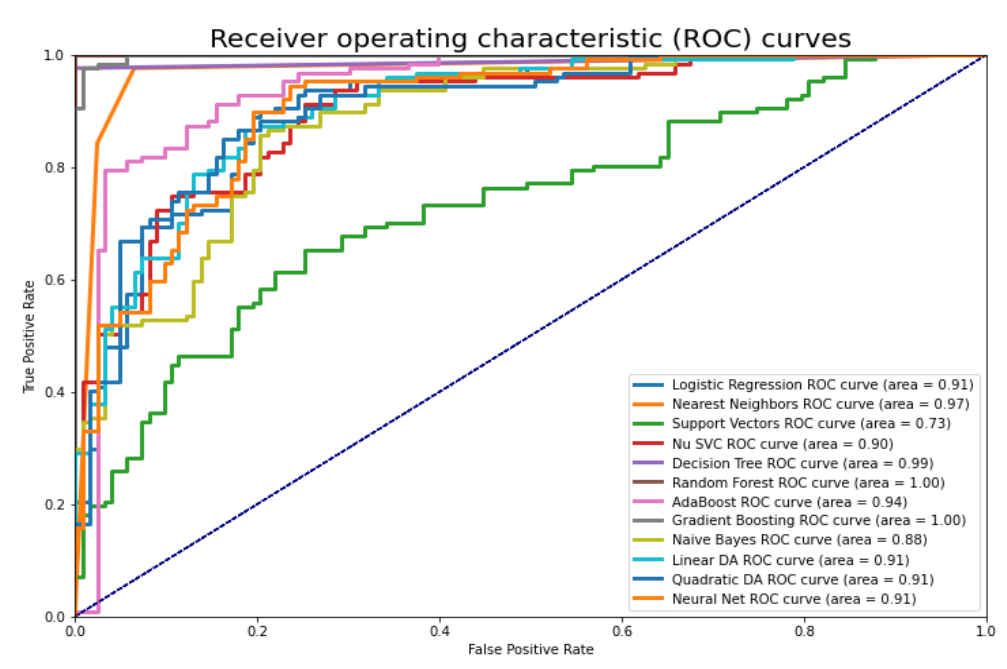
Figure 17. Combine plots for ROC-AUC.